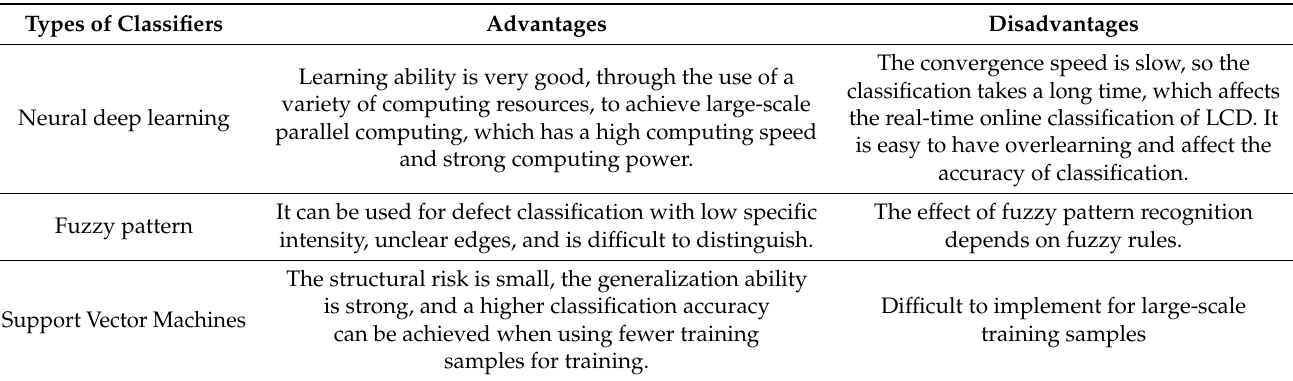
Table 4. Comparison of classifiers for Mura